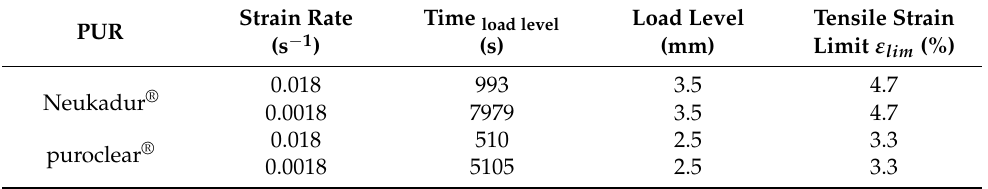
Table 3. Strain limits ε lim determined using the thermographic analysis for Neukadur ® and puroclear ® under tensile load.